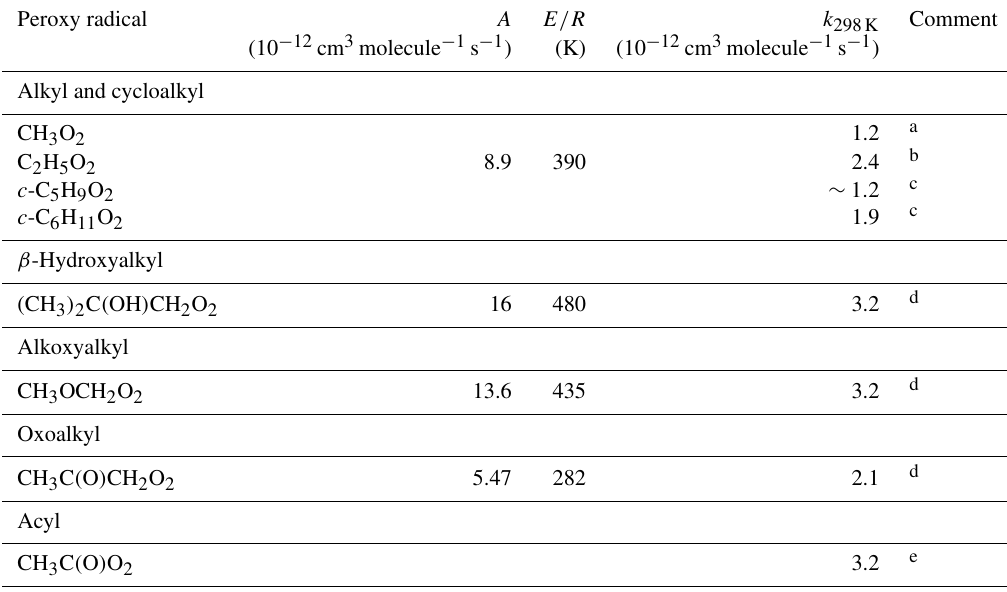
Table 5. Kinetic data for the reactions of alkyl and oxygenated peroxy radicals with NO 3 . Where available, the temperature dependence is given by k = A exp ( − E/RT ) .